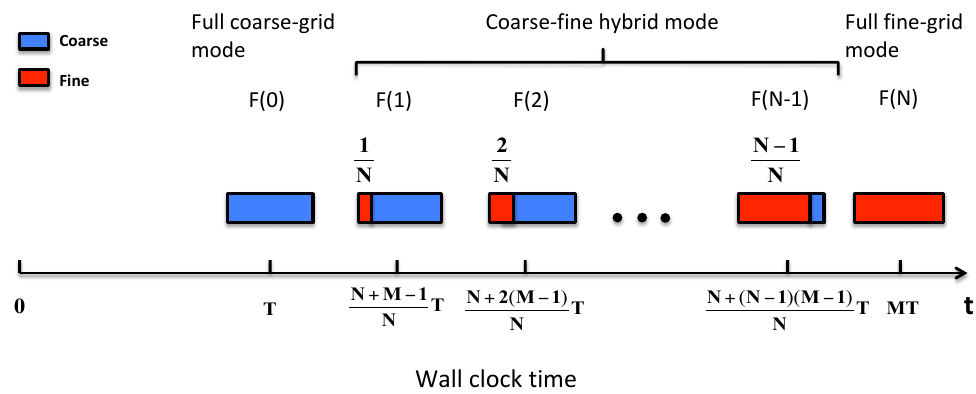
Figure 2. The framework of the multi-model integration. The blue and red squares represent the coarse-grid and fine-grid simulations,